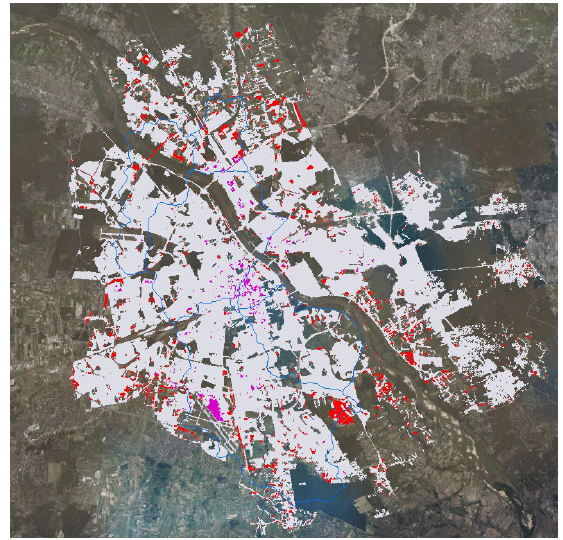
Figure 2. Imperviousness Layer for Warsaw. (Copernicus Program,